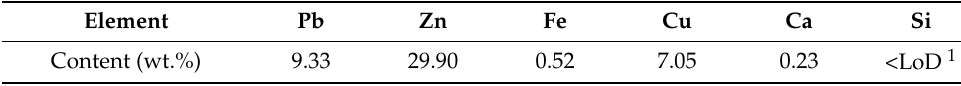
Table 1. Chemical analysis of converter dust.